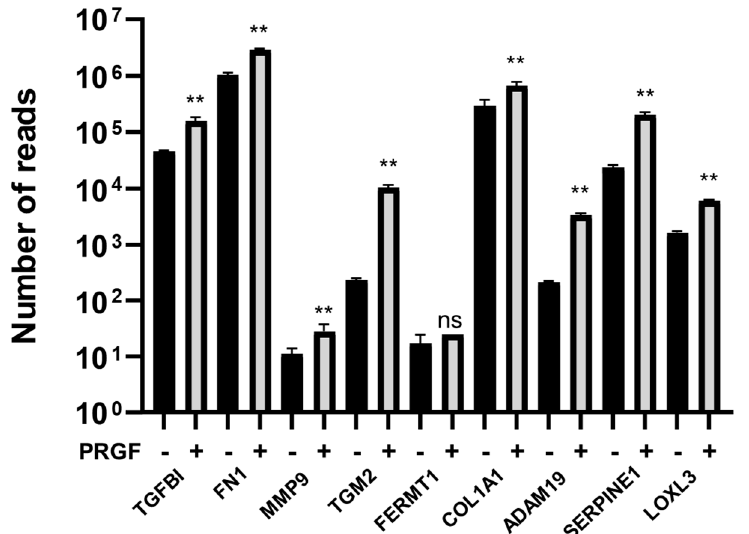
Figure 1. Whole transcriptome sequencing of PRGF-treated fibroblasts revealed induction of ECM- related genes. Human primary fibroblasts were treated with or without PRGF for 24 h. After stimulation, total RNA was isolated and used for whole transcriptome sequencing. Shown are means of the number of reads ± s.e.m. ( n = 5, ** p < 0.01, ns = non-significant, Mann-Whitney U test).